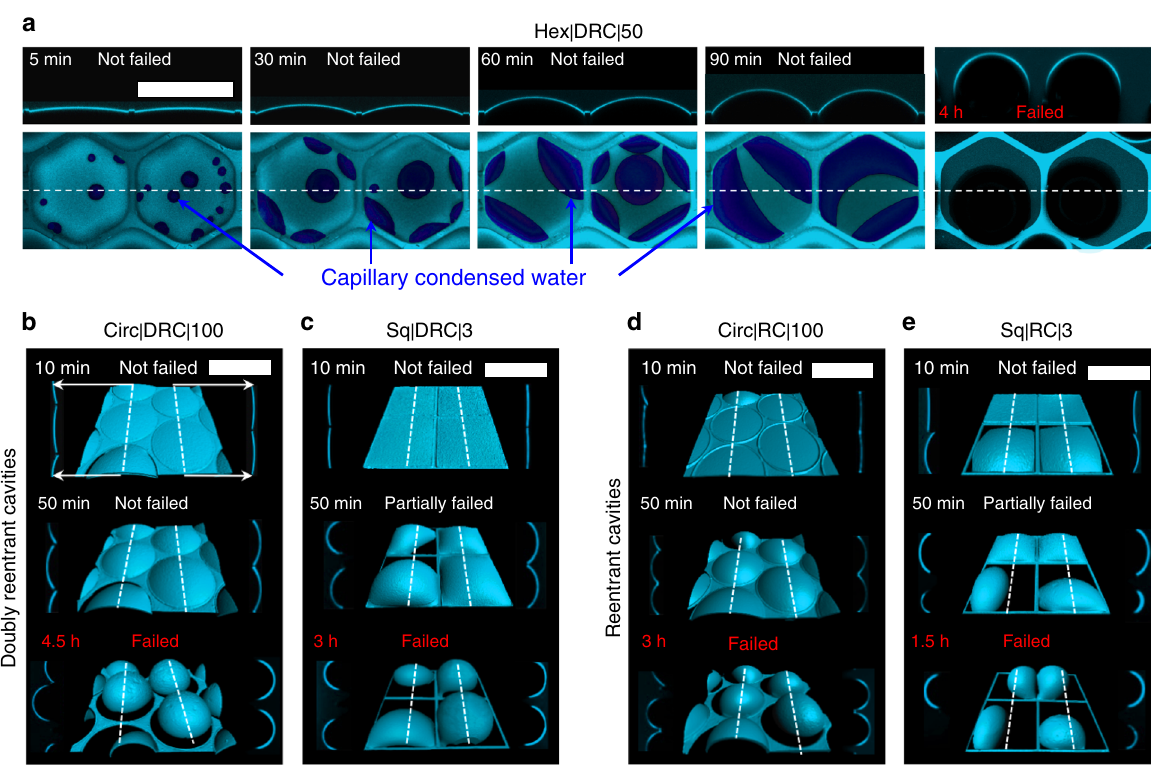
Fig. 4 Confocal microscopy images of silica surfaces with reentrant and doubly reentrant cavities immersed in water. a Mechanisms underlying the loss of air trapped in a hexagonal DRC on immersion in water and observed via confocal microscopy. The snapshots on top are the cross-sectional views of the top-views below at different times along the white dotted line. The light blue color in the images corresponds to the air-water interface on top that has been rendered partially transparent, while the dark blue color corresponds to the capillary condensed water at the bottom of the cavity. On immersion, the intruding water meniscus was stabilized at the doubly reentrant and reentrant edges. Over next 5 – 90 min, the capillary condensation of water inside the cavities led to the formation of small droplets that merged over time to form thick fi lms. This volume of water displaced the trapped air causing upward bulging, which initiated the diffusion of trapped air in the water even before t failing . Eventually the condensed water touched the primary meniscus on top and the cavity was invaded by water. b – e Computer-enhanced isometric reconstructions (center) along with cross-sectional views along the dotted lines (on either sides of the central image) of representative confocal images of water menisci after immersing silica surfaces with DRCs and RCs of circular and square shapes under a 5 mm high column of water. We observed that circular DRCs and RCs exhibited higher t failing than square ones and DRCs outperformed RCs. (Scale bars: 200 µ